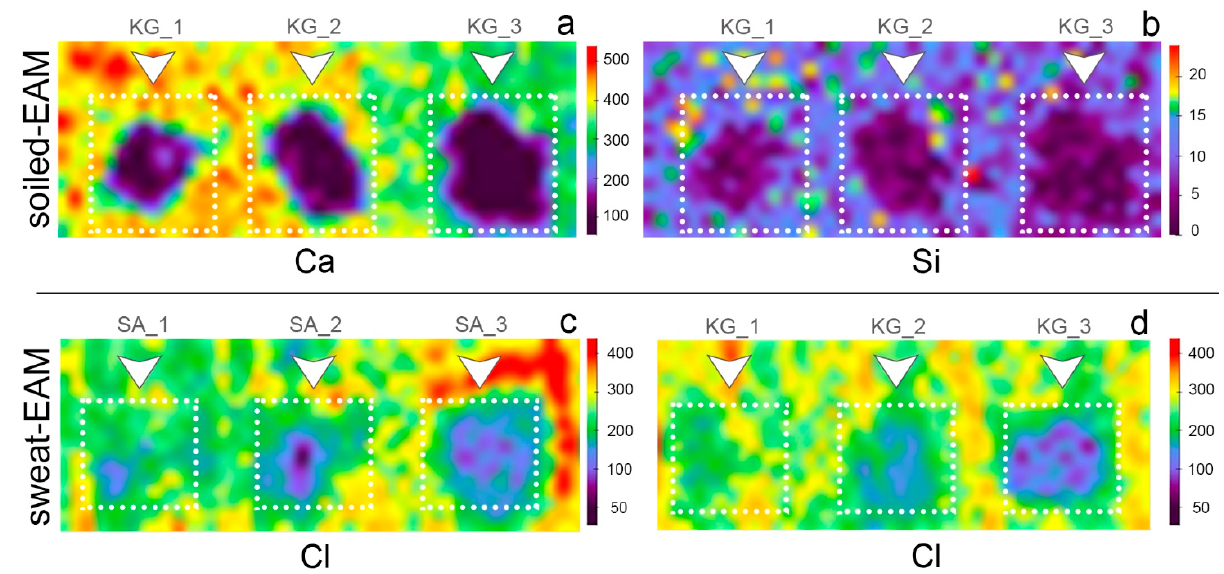
Figure 8. XRF maps of ( a ) Ca (K α ) and ( b ) Si (K α ) on the soiled-EAM after cleaning trials with KG gel (KG_1, KG_2, KG_3, respectively from left to right); XRF map of Cl (K α ) on the sweat-EAM after cleaning trials with ( c ) SA and ( d ) KG gels at different application times (SA_1, SA_2, SA_3, KG_1, KG_2, KG_3, respectively from left to right). Table 4. Normalized counts of Cl (K α ) on sweat-WM and sweat-EAM, before (control) and after different cleaning applications with SA and